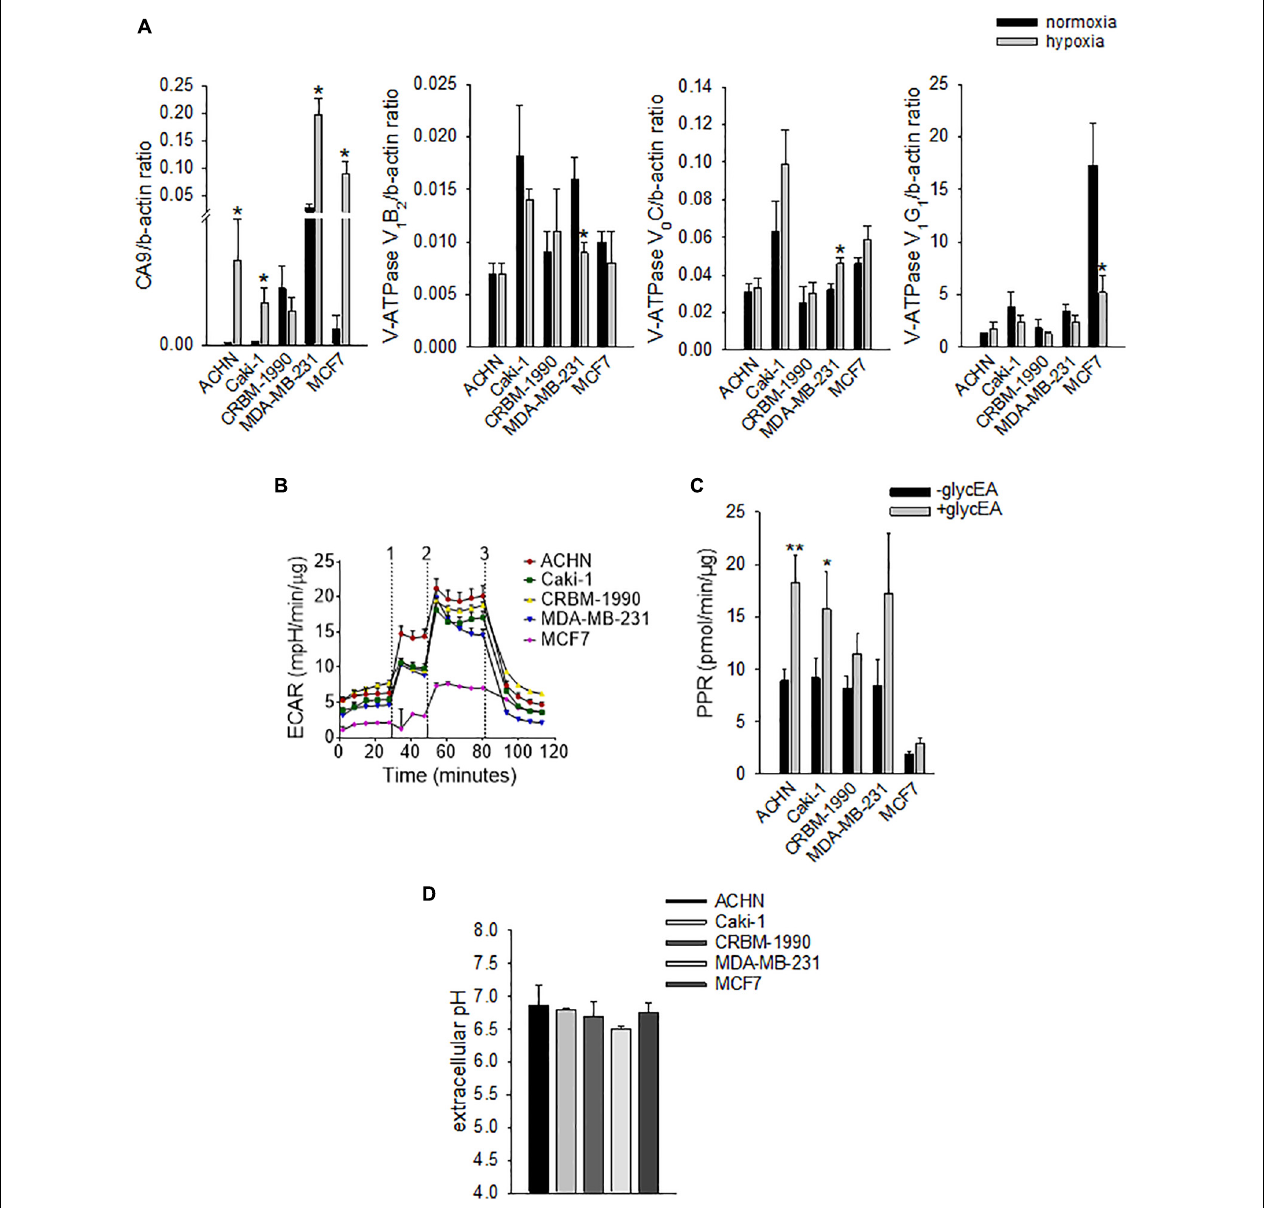
FIGURE 2 | Carcinoma cells acidify the extracellular space by using different proton/ion transporters. (A) mRNA levels of CA9 and V-ATPase subunits (V 1 B 2 , V 0 C, and V 1 G 1 ) under normoxia (21% O 2 ) and hypoxia (1% O 2 ). Mean ± SEM ( n = 4 for CA9 and V 0 C, and n = 6 for V 1 B 2 and V 1 G 1 , * p < 0.05). (B) Representative graph of extracellular acidification rate (ECAR); 1, 2, and 3 are the respective time-points for the injection of glucose, oligomycin, and 2-deoxy- D -glucose. (C) Extracellular acidification ability of carcinoma cell lines as determined by the measurement of the proton production rate (PPR); PPR values obtained before the addition of glucose represent non-glycolytic extracellular acidification ( − glyc EA), in contrast to the values obtained after the addition of glucose ( + glyc EA). Mean ± SEM ( n = 45, * p < 0.05). (D) Extracellular acidification ability of carcinoma cell lines. The unbuffered pHMed solution was incubated with the respective cell suspension and measurement of extracellular pH was obtained by using a pH micro-electrode. Mean ± SEM ( n =